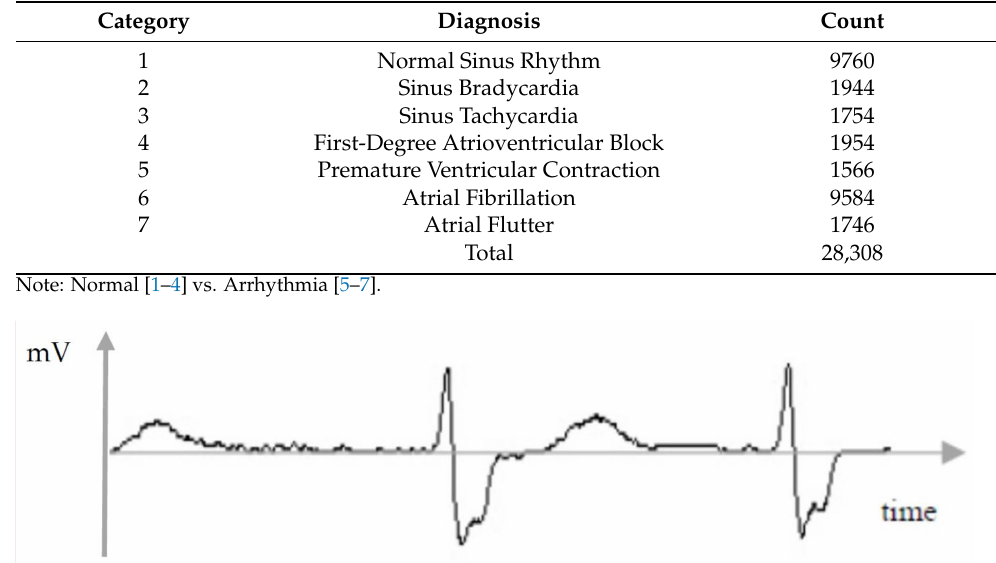
Figure 1. Electrocardiogram